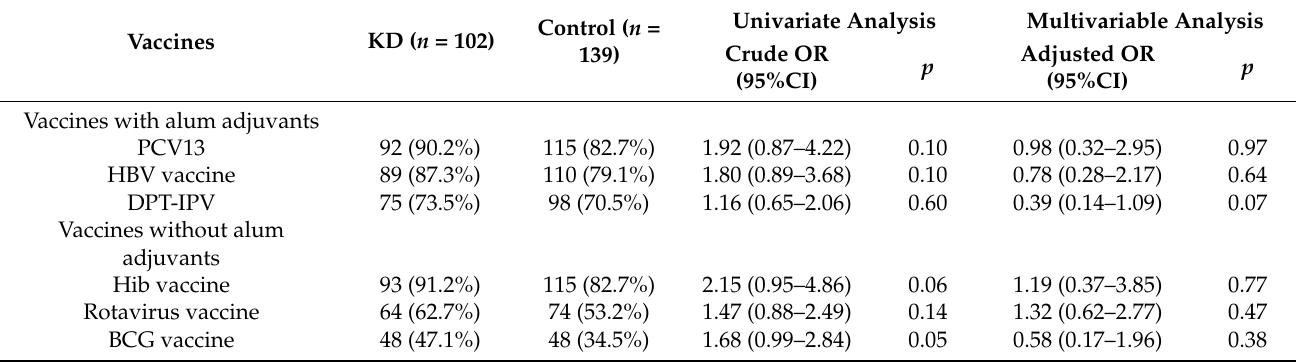
Table 2. Comparison of the vaccination status by univariate and multivariable analyses.